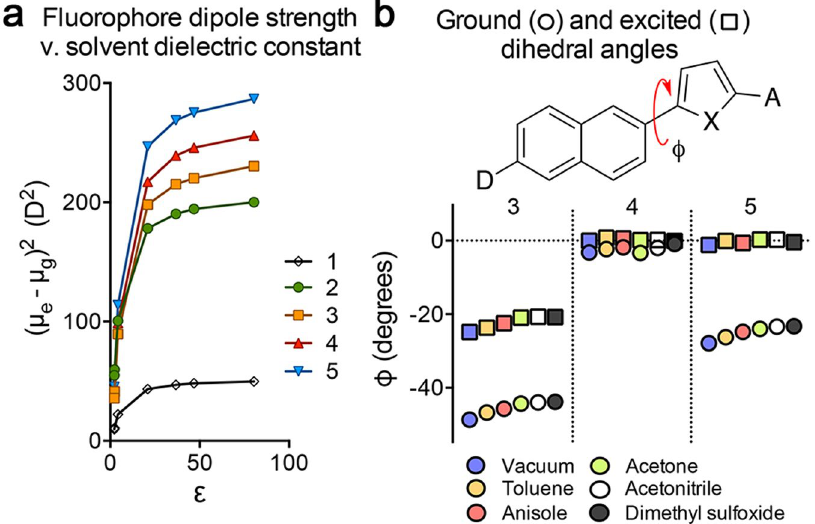
Figure 4. Calculated molecular dipole and torsional strain for AACA probes as a function of the environment polarity. ( a ) Square of the difference of the ground and excited states dipole moments as a function of the environment dielectric constant ( ε ). ( b ) Calculated dihedral angles between the naphthalene and heterocyclic aromatic rings of the ground ( ○ ) and excited ( □ ) states for AACA probes 3–5 in polar aprotic solvents. X = NMe (AACA 3 ), O (AACA 4 ), and S (AACA 5